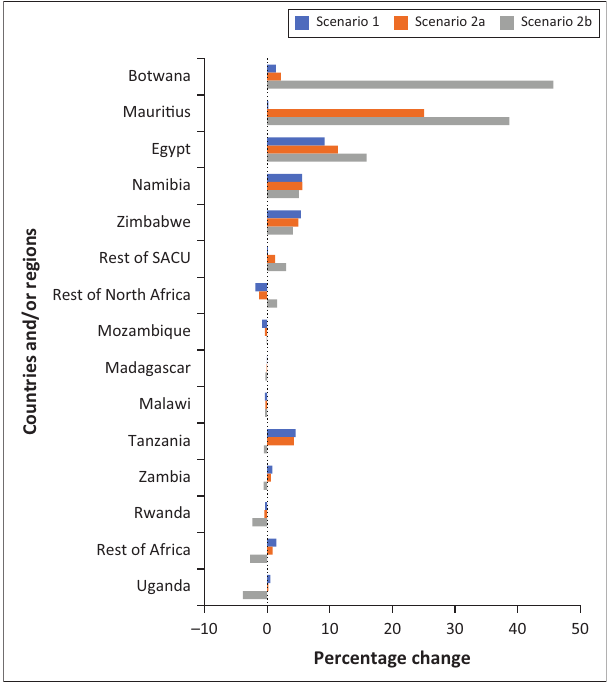
FIGURE 5: Summary of regional welfare changes ( % change in US$) in countries/ regions other than the top 5 (ranked according to Scenario 2b